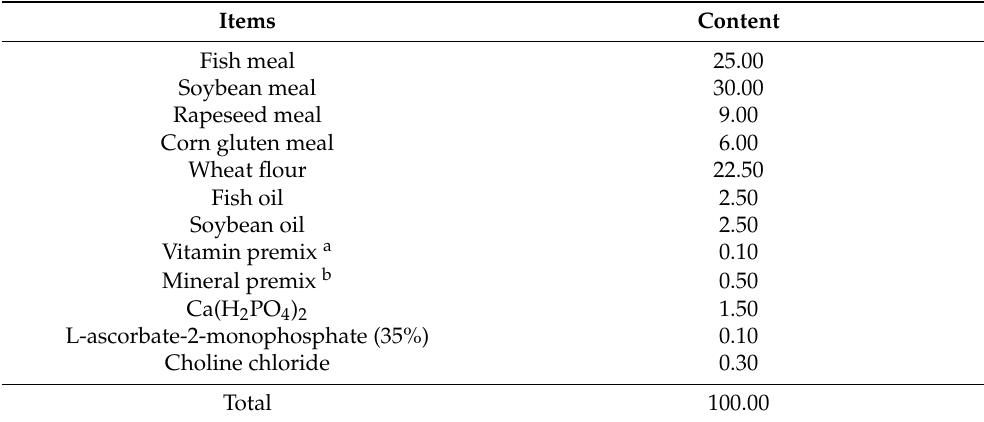
Table 1. Composition of experimental diet (DM basis)